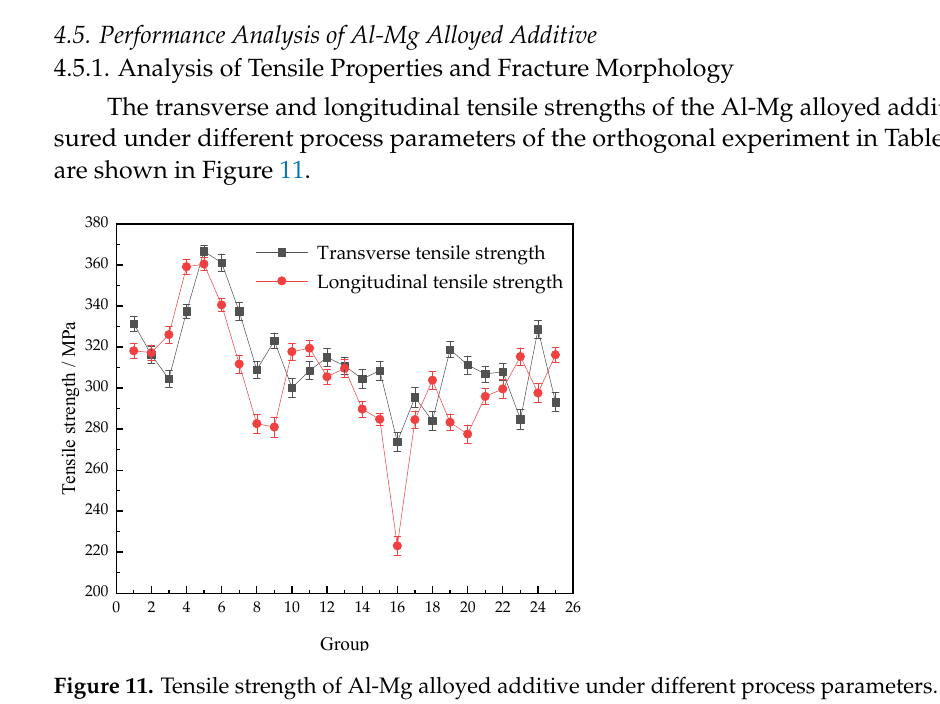
Figure 10. Orientation distribution diagram of Al-Mg alloyed additive.